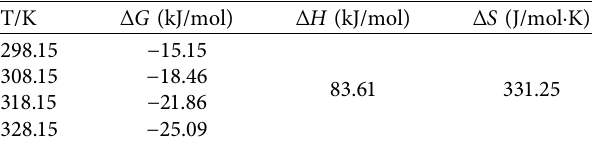
Table 3: Termodynamic properties of CMC-LTO-EGDE spheres adsorption.